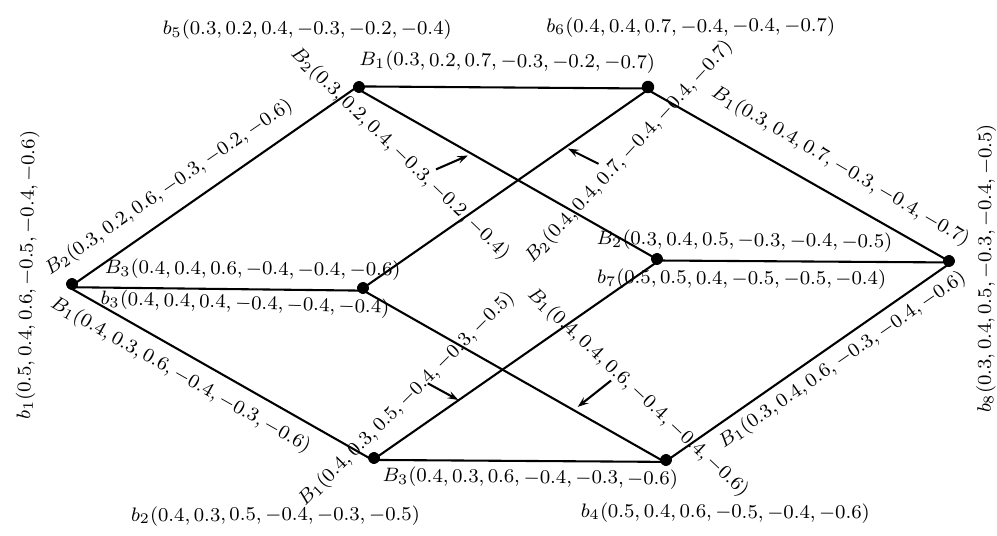
Figure 1. A BSVN graph Figure 2.1: A bipolar single-valued neutrosophic graph structure